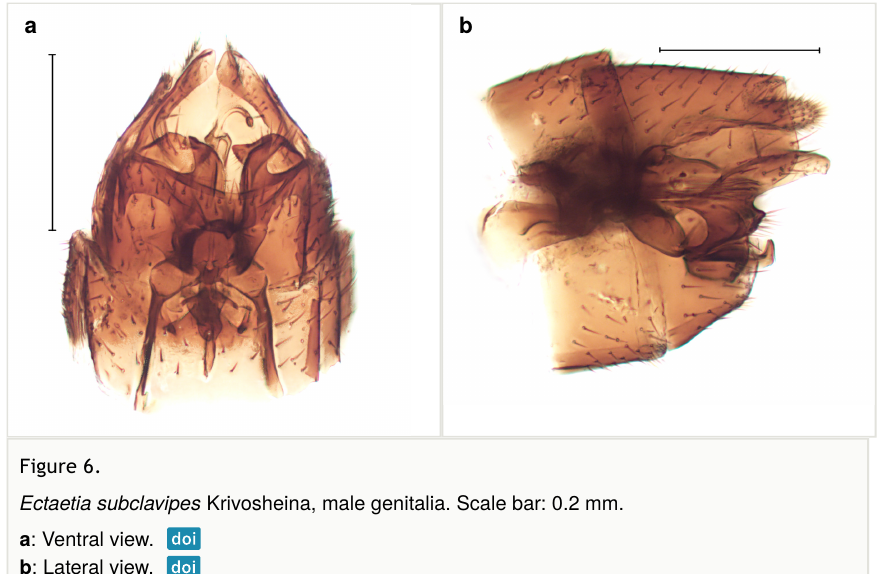
Figure 6. Ectaetia subclavipes Krivosheina, male genitalia. Scale bar: 0.2 mm. a : Ventral view. b : Lateral